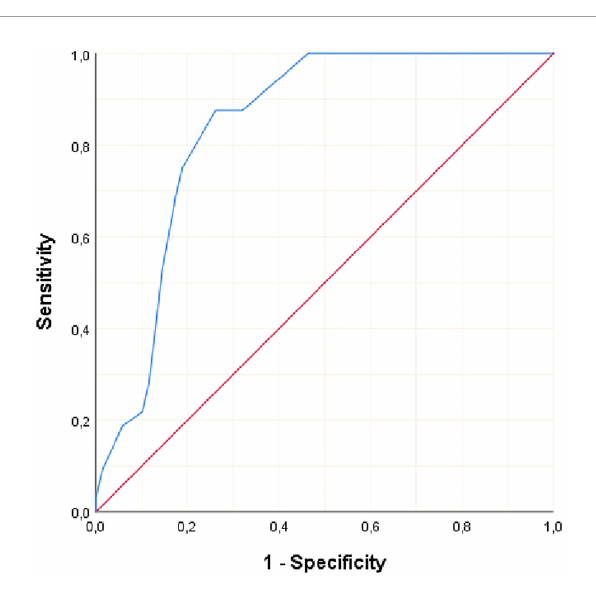
FIGURE 2 ROC analysis of maximum MLN diameter to predict mortality of the CRC patients.